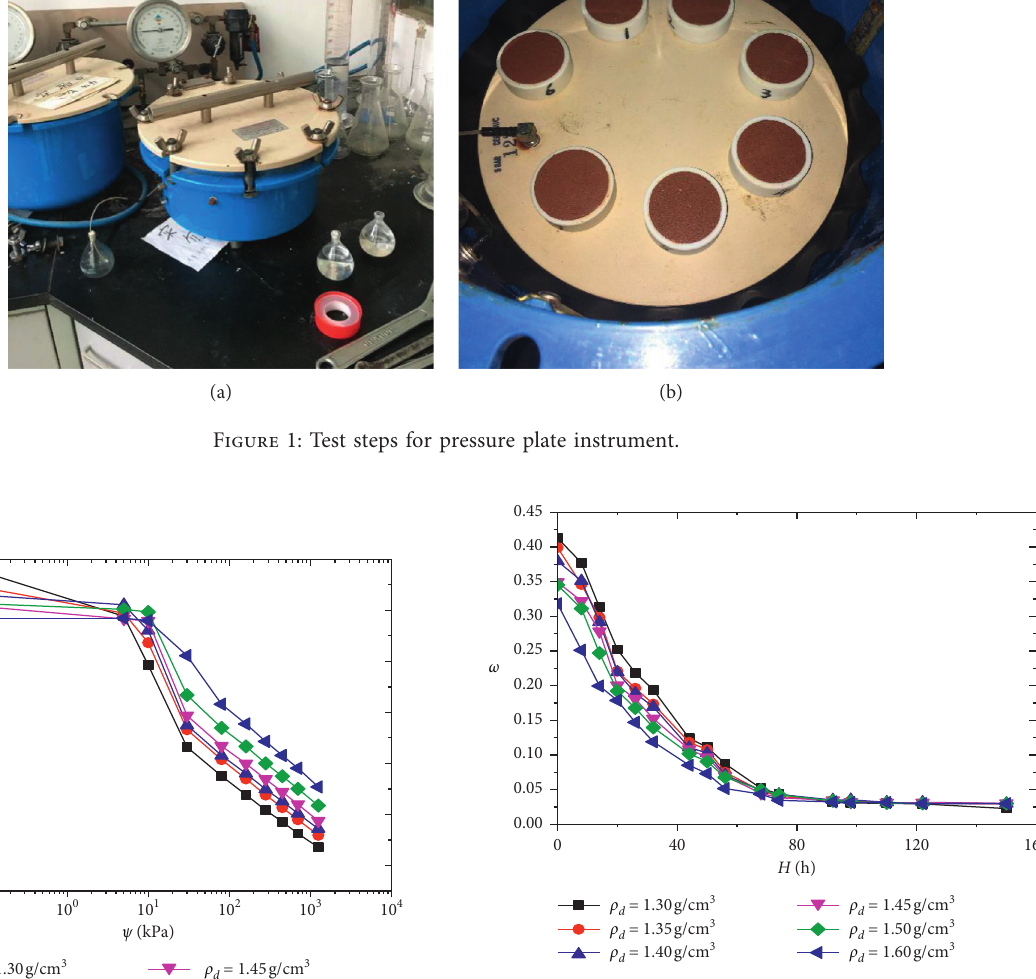
Figure 3: Variation curve of mass water content of Hunan clay with time. Table 2: Residual water content determined by evaporation test.